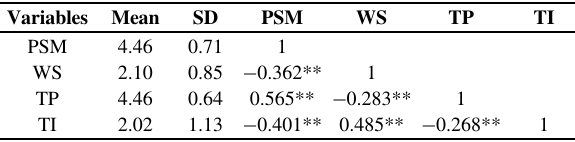
Table 2 Correlations among public service motivation, task per- formance, work stress, turnover intention. Variables Mean